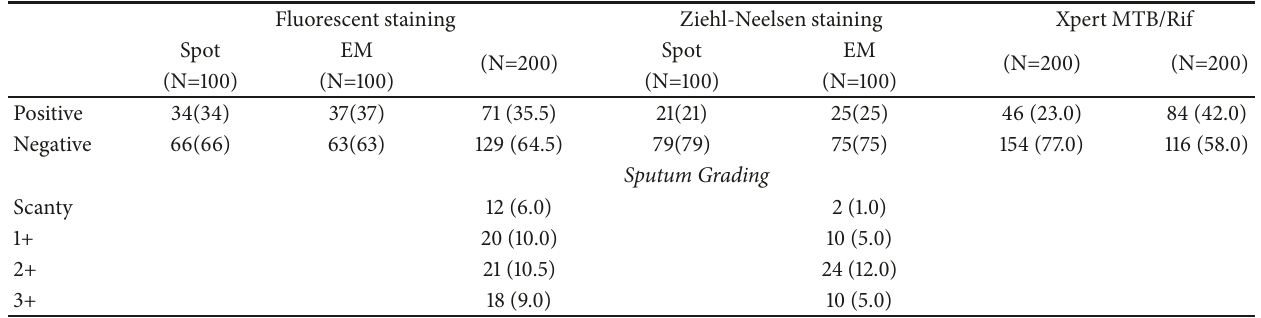
Table 1: Comparison of diagnostic tests used.